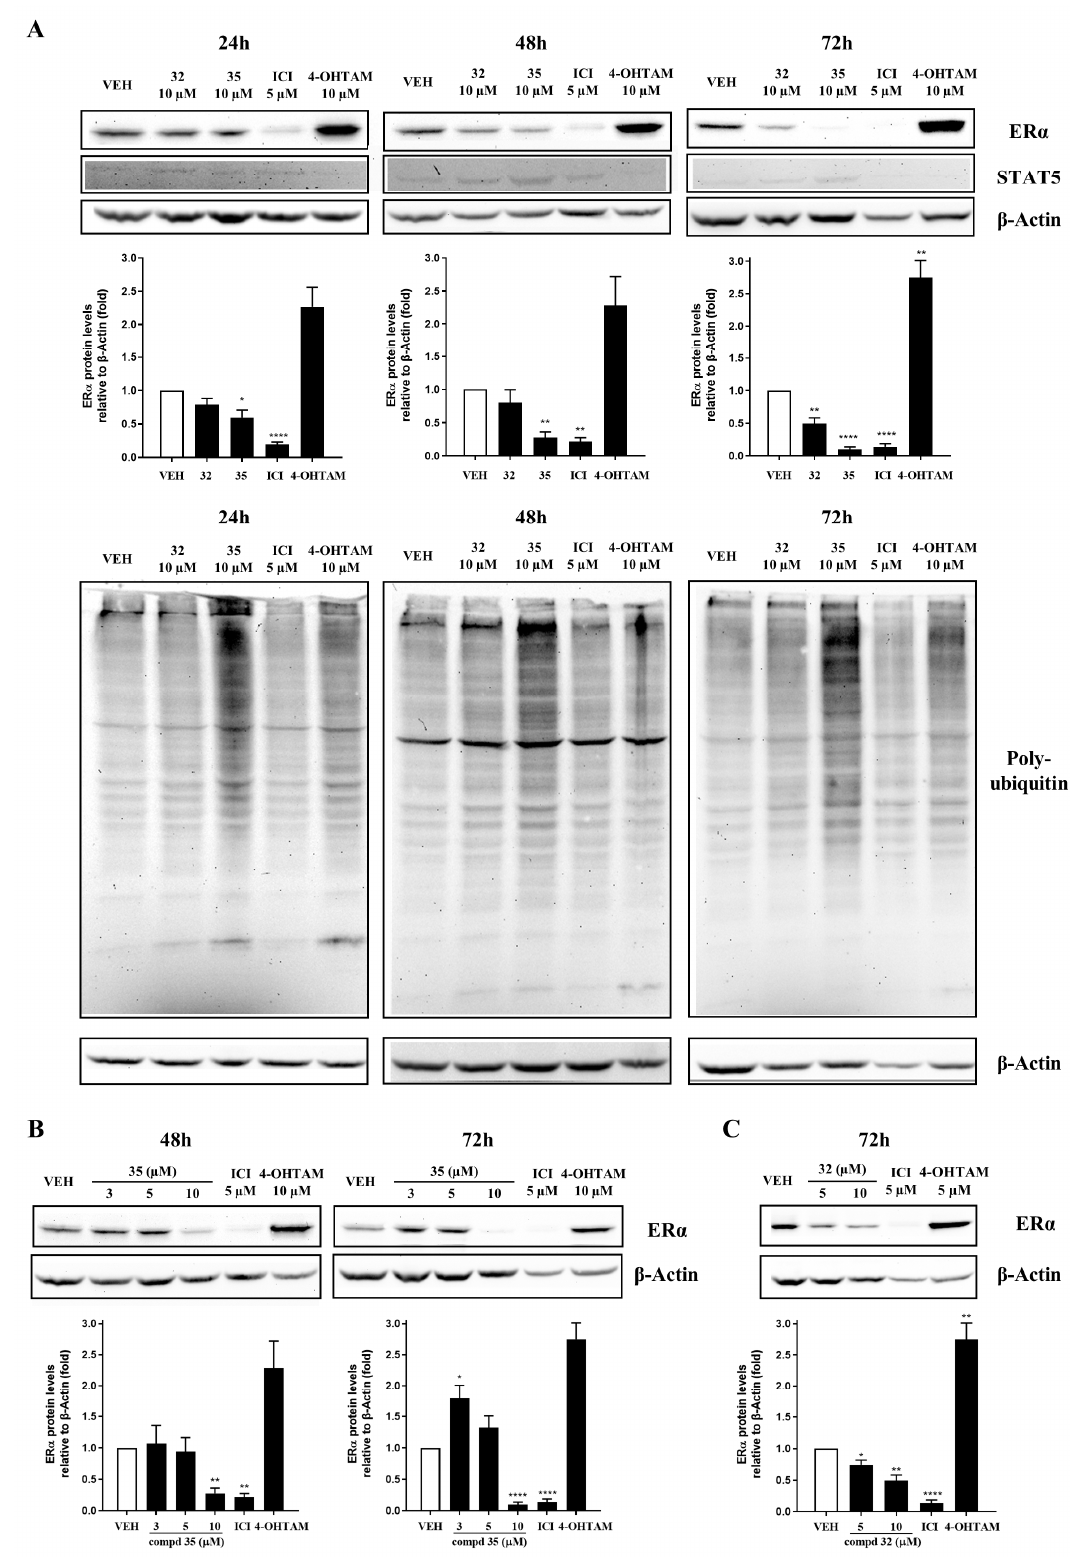
Figure 14. 5-Hydroxy-2 H -pyrrol-2-ones 32 and 35 decrease ER α protein levels in human ER+ breast cancer cells in a time and dose dependent-manner by two differentiated mechanisms.